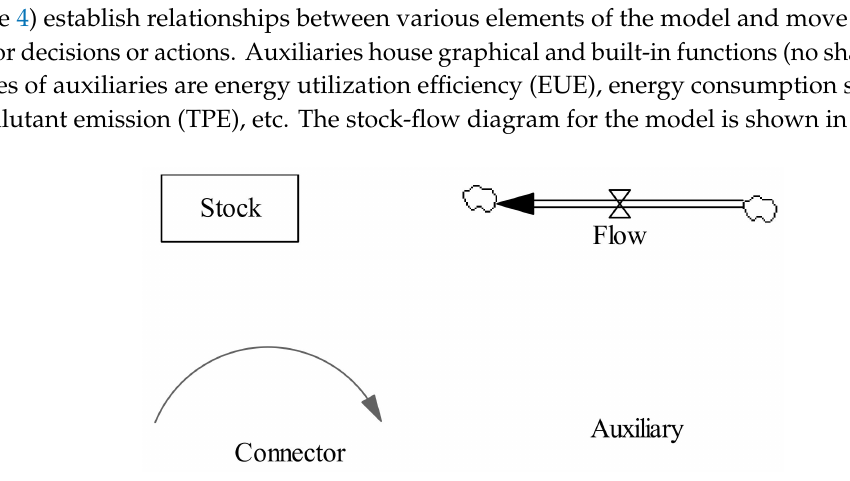
Figure 4. Building blocks of system dynamics